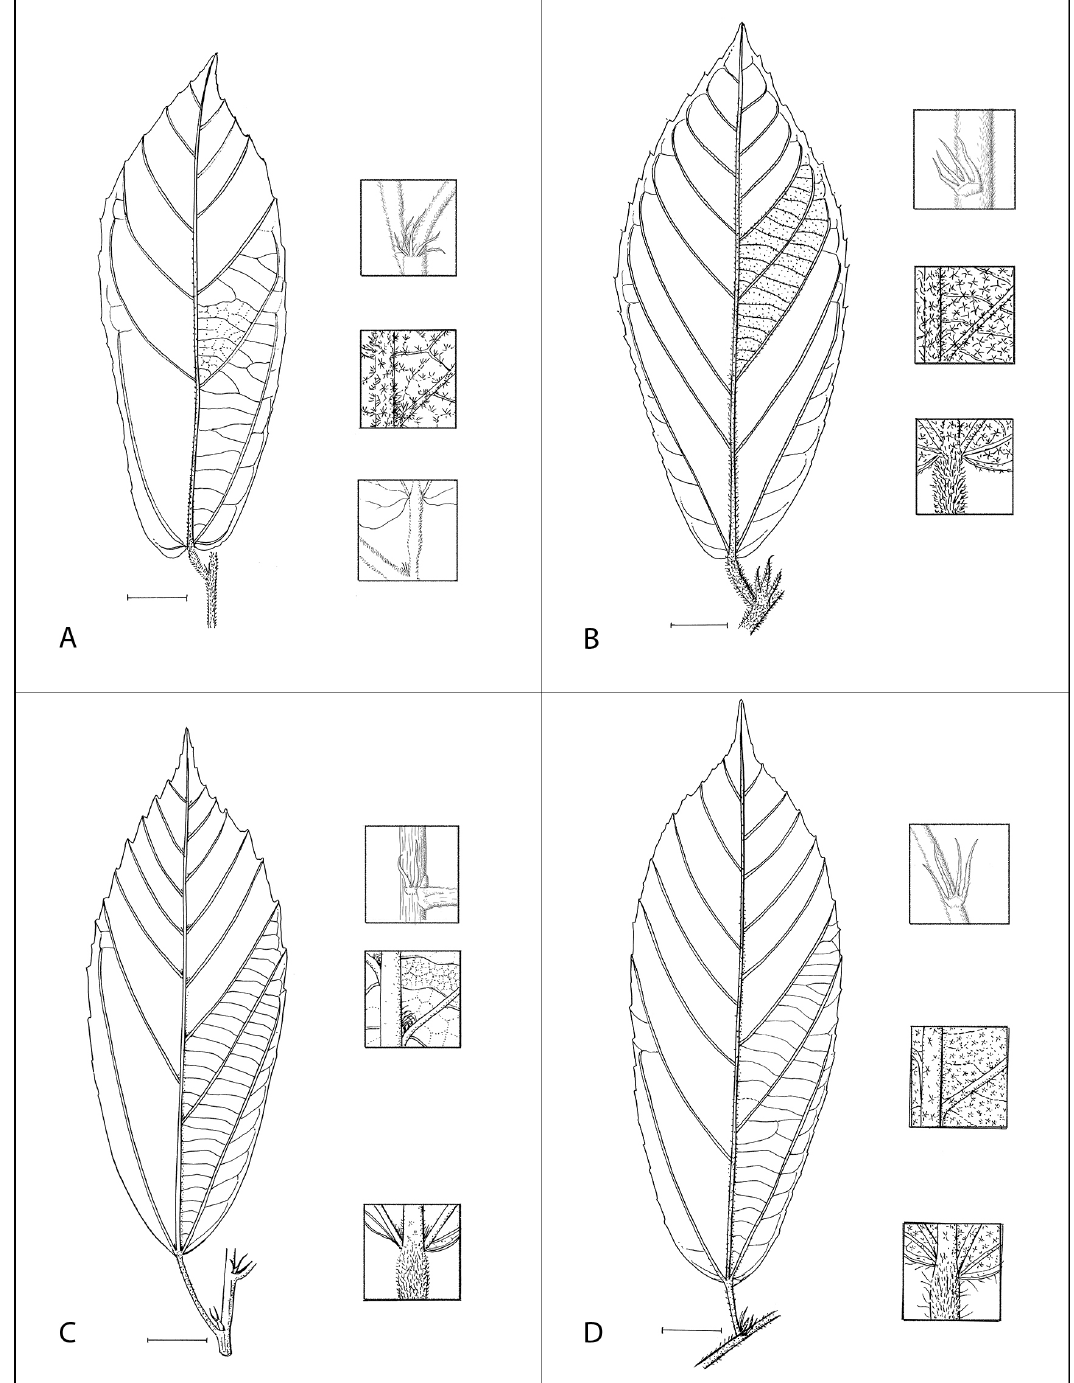
Fig. 1. Illustration of Desplatsia Bocq. leaves. A . D. subericarpa Bocq. ( Harris 1387 (E)). B . D. chrysochlamys (Mildbr. & Burret) Mildbr. & Burret ( Harris 5402 (E)). C . D. dewevrei (De Wild. & T.Durand) Burret ( Harris 7025 (E)). D . D. mildbraedii Burret ( Harris 4397 (E)). Scale bars = 2 cm. Boxed enlargements of petiole (in B–D) and midrib (A–D) are magnified 10 × to represent the view through a typical 10 × hand lens. Boxed enlargements of petiole (A) and stipules (A–D) are magnified 6 ×. Images are taken from Harris & Wortley (2008), illustrated by Rosemary Wise, with additional enlargements by Sanna